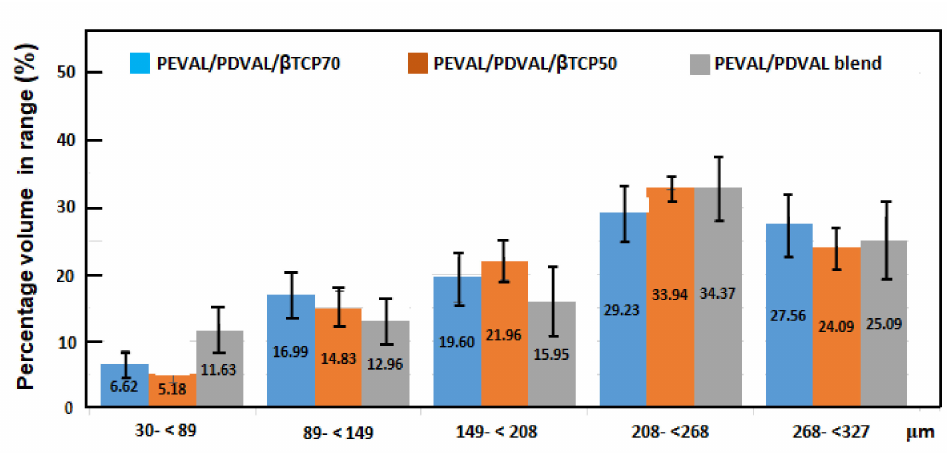
Figure 7. Percentage of pore size ranges among the PEVAL/PDVAL blend, and the PEVAL/PDVAL/ β -TCP50 and PEVAL/PDVAL/ β -TCP70 hybrid materials, as determined by